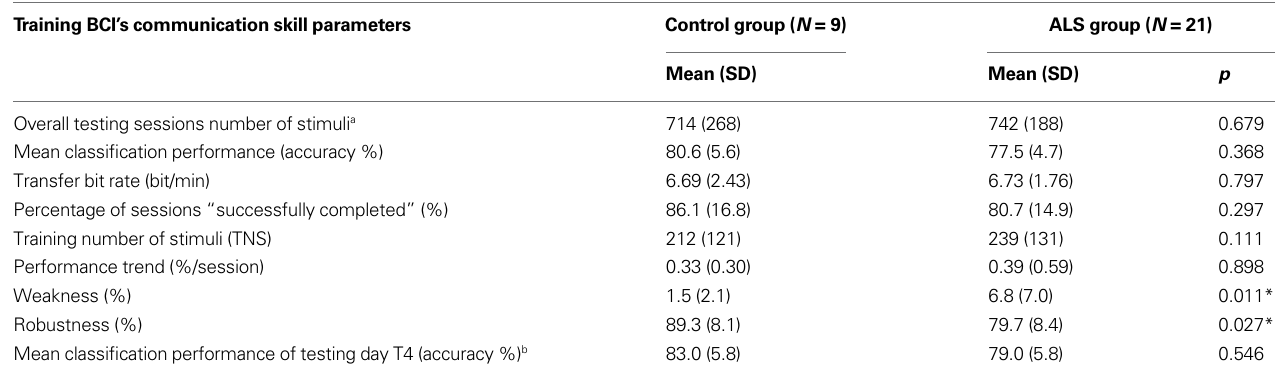
Table 7 | BCI measures related to the training BCI-test (i.e. 16 sessions: T1, T2, T3, and T4).